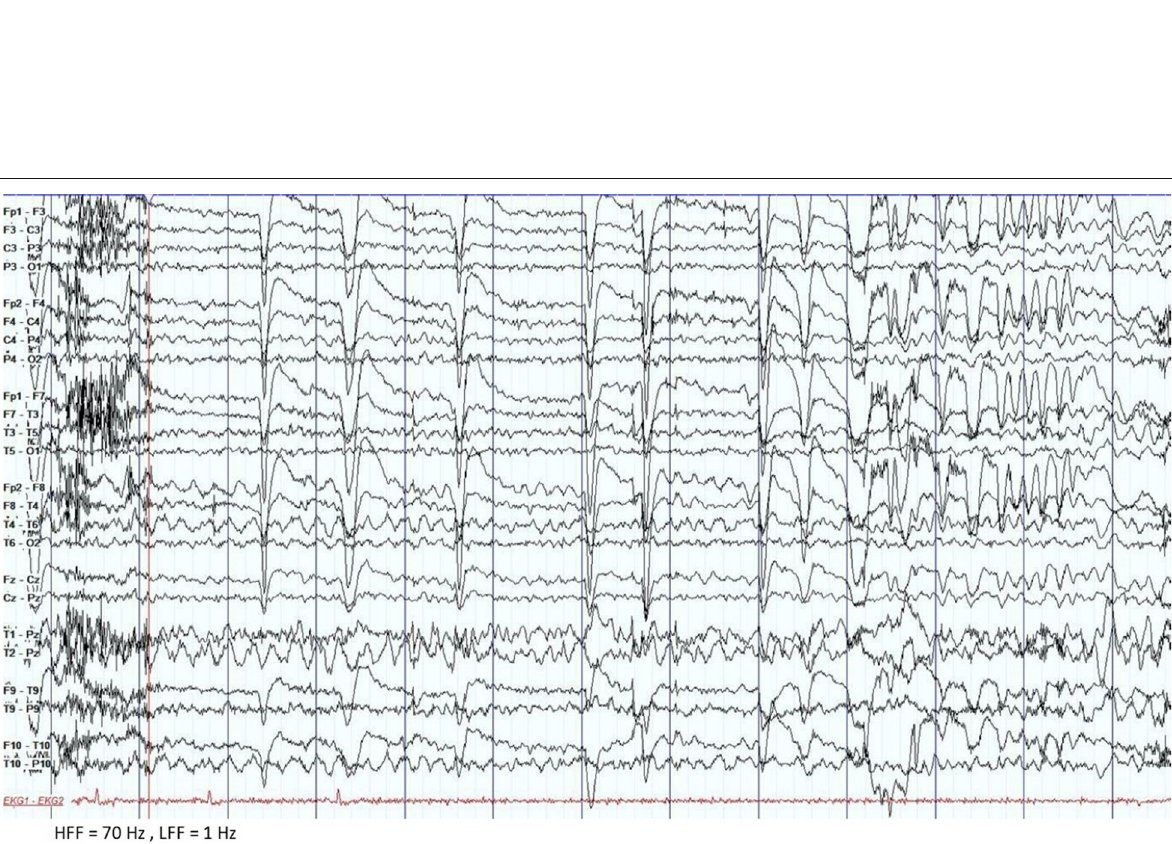
Fig. 2 Epoch B of the EEG recording demonstrates onset of IA. Heart rate drops from 90 beats per minute to 60 beats per minute. Seven seconds later, the patient develops asystole for 10